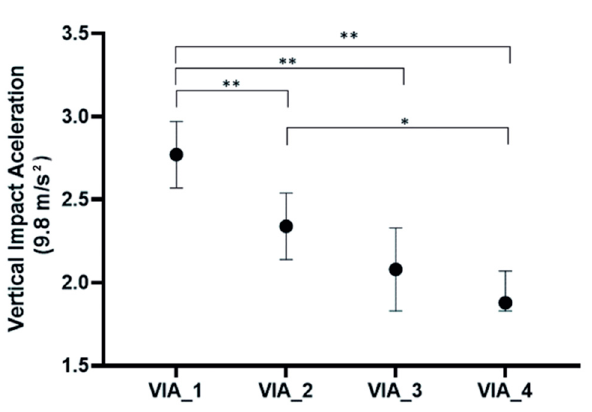
Figure 2. Vertical impact acceleration in four consecutive sectors with a similar slope of a vertical race. VIA: Vertical impact acceleration. * p < 0.05; ** p < 0.01 in Bonferroni’s post-hoc test. Multiple linear regressions showed a model with weight and GT as dependent variables of mean speed (Equation (3)). This model presented a R 2 = 0.732 and an adjusted R 2 = 0.678 ( p = 0.025). Model predictive capacity was statistically significant ( p =0.001). The model’s coefficients were statistically significant (A = 0.179, p = 0.05; B = − 0.028, p = 0.025); however, the model’s constant was not (C = 0.907, p = 0.468).Standardized coefficients were A beta = 0.615 and B beta = -0.448,respectively.